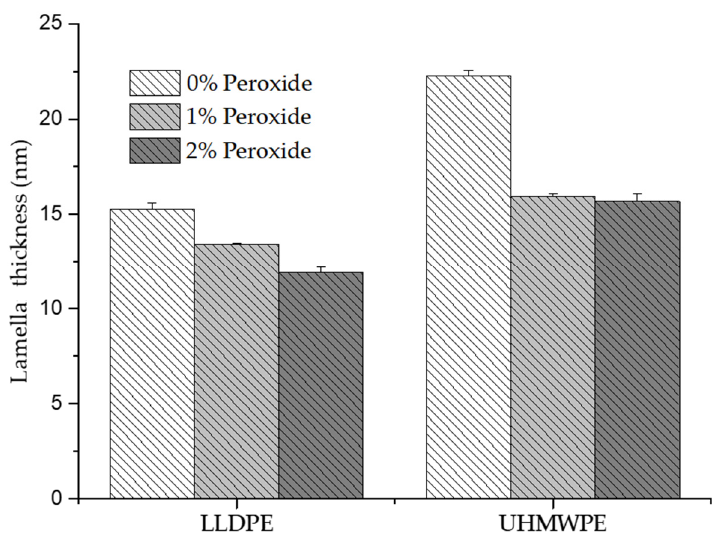
Figure 12. Thickness of the lamella determined by DSC for the LLDPE is UHMWPE with 0%, 1% and 2% peroxide.